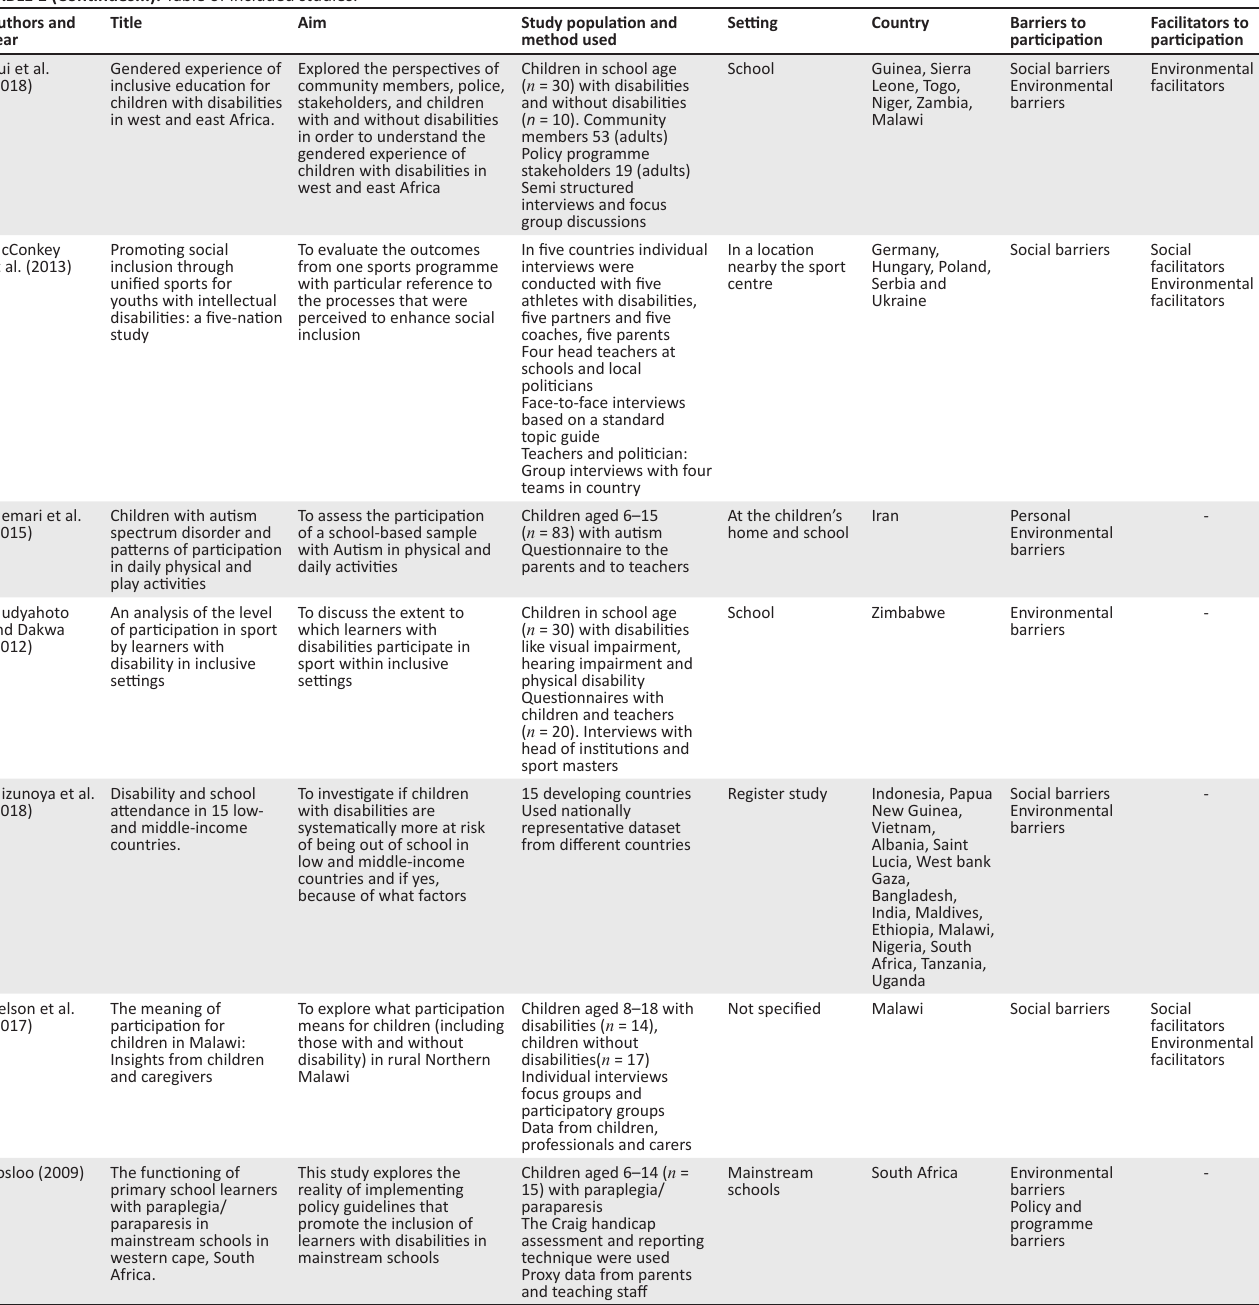
TABLE 1 (Continues...): Table of included